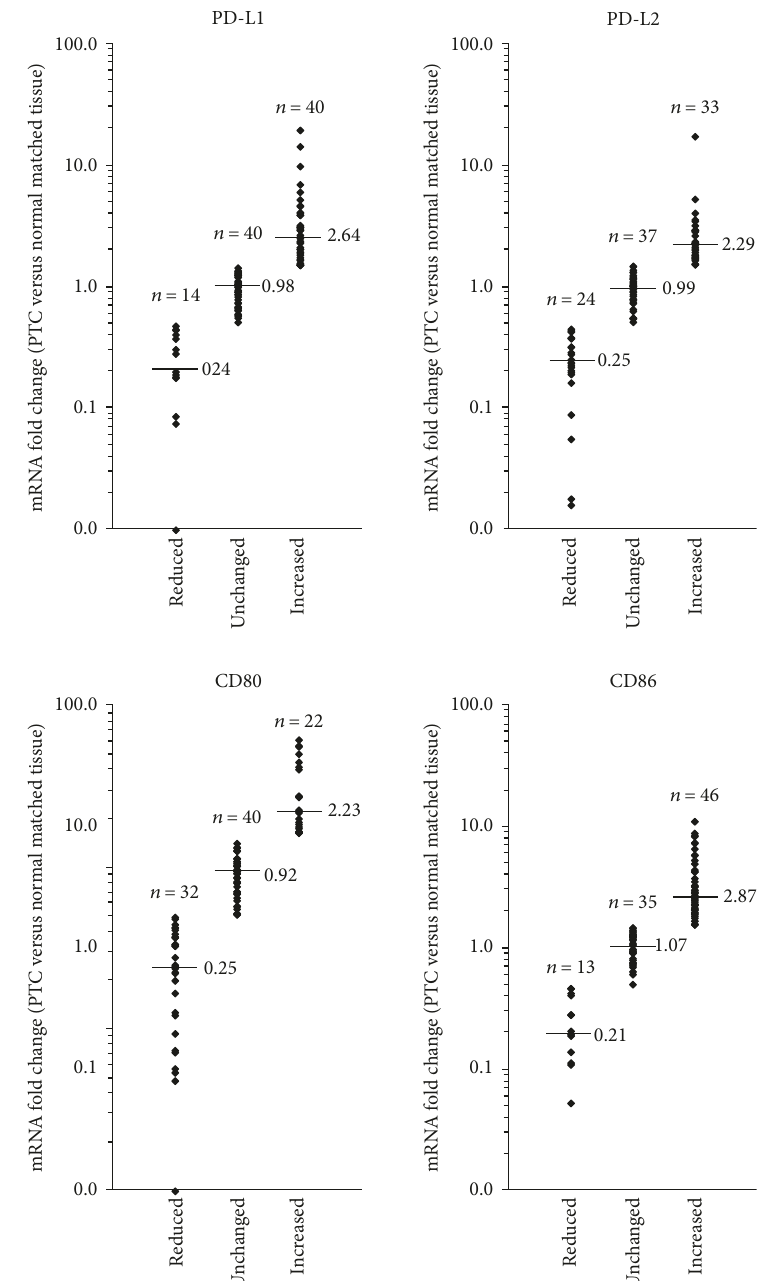
Figure 1: Relative expression levels of PD-L1 , PD-L2 , CD80 , and CD86 mRNAs in PTC tissues. The fold changes were calculated considering the mRNA values of normal matched thyroid tissues equal to one. Referring to mRNA fold change, three groups are showed (i.e., reduced, unchanged, and increased). For each group, “ n ” indicates the number of cases. The small bars in the graph indicate the median